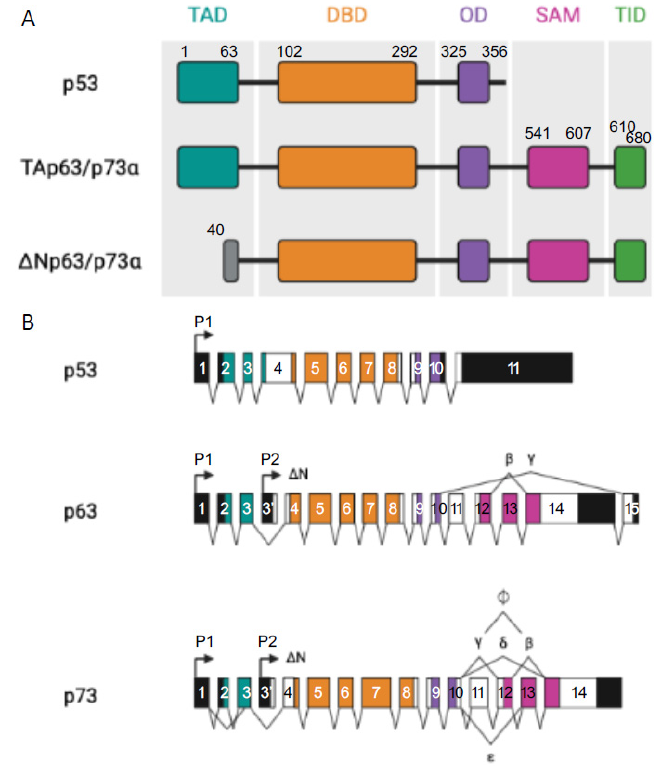
Figure 1. p53 family members. ( A ) Representation of the different domains in p53 and TA and Δ N p63 α and p73 α isoforms: transactivation domain (TA, in light grey), DNA binding domain (DBD, in red), oligomerization domain (OD, in yellow), sterile alpha domain (SAM, in dark grey), and the transactivation inhibitory domain (TID, in orange), introns (black lines). ( B ) Represents p53, p63, and p73 multiple spliced variants. P stands for different promoters, numbered boxes indicate exons, black boxes are untranslated sequences, and black lines are introns.